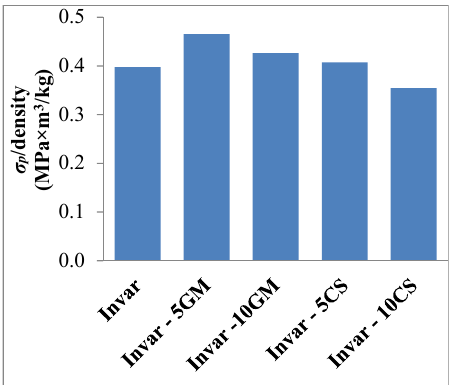
Figure 9. The plateau onset stress over density of Invar SFs in comparison to the yield strength over density of Invar matrix materials. The data of Invar SFs ‐ filled glass microballoons is reported in reference [20].